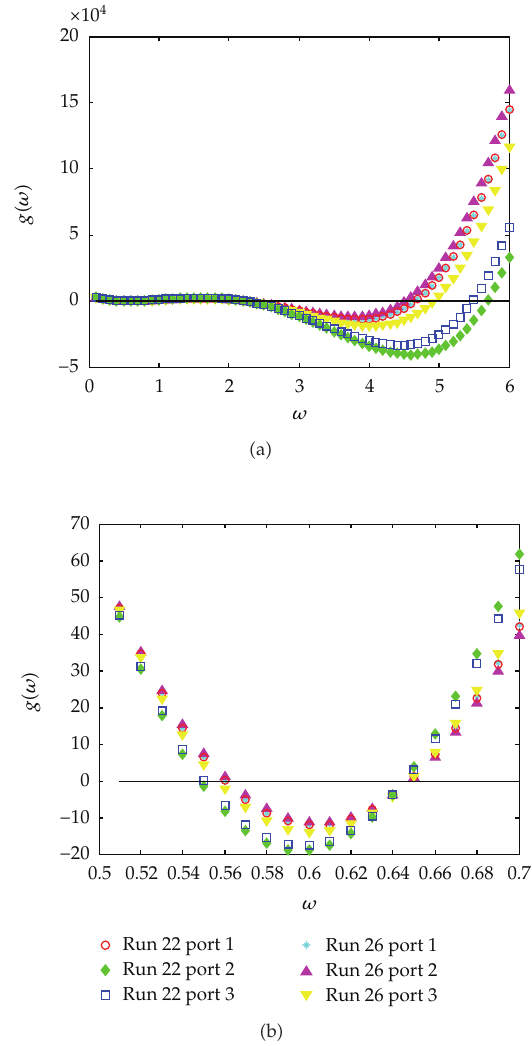
Figure 6: g (cid:2) w (cid:3) for Runs 22 and 26 over (cid:2) a (cid:3) a wide range of ω from 0 to 6 and (cid:2) b (cid:3) a narrow range of ω